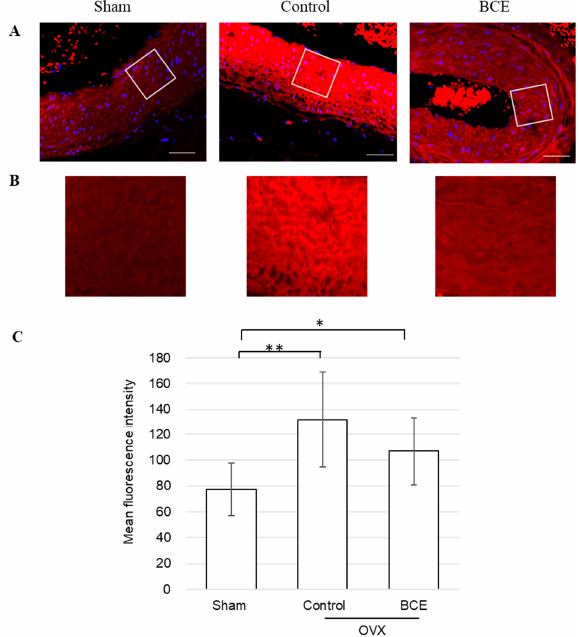
Figure 3. Representative images of immunofluorescence-stained tissues, evaluated for α -SMA protein expression. ( A ) Smooth muscle cells stained with TRITC (red) and counter-stained with DAPI (blue) to visualize the nuclei (400× magnification; scale bar = 50 μ m). ( B ) Fluorescence intensity of the images enlarged for clarity. ( C ) Quantification of α -SMA protein fluorescence. Data are shown as means ± SEM; n = 11 (Sham), n = 12 (Control) and n = 11 (BCE). * p < 0.05, ** p < 0.01. OVX, ovariectomized; BCE, blackcurrant ( Ribes nigrum L.) extract; SMA, smooth muscle actin; SEM, standard error of the mean.